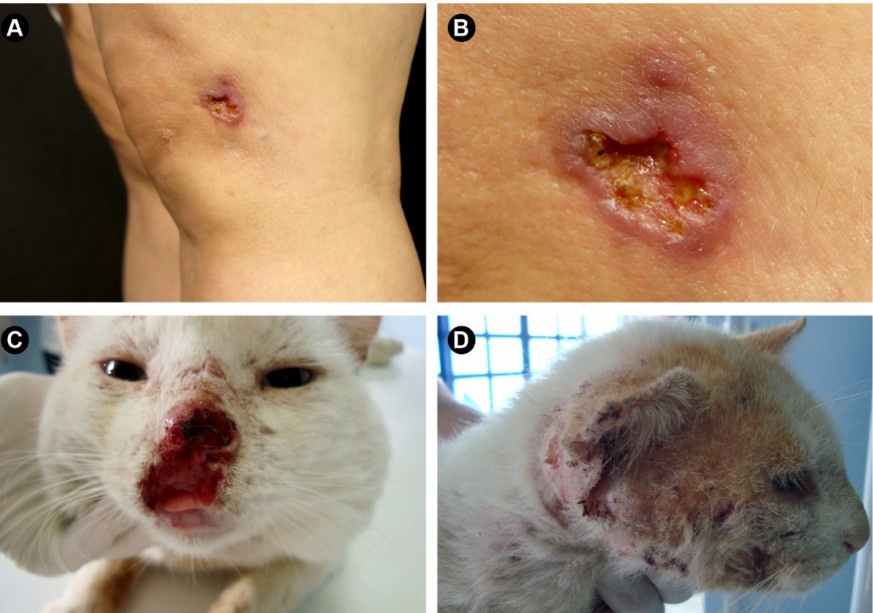
Figure 2. Human and feline sporotrichosis. ( A , B ) Human sporotrichosis on the left knee. ( C , D ) Feline sporotrichosis with lesions in the nasal and cephalic region. Images of cats with sporotrichosis were kindly provided by Prof. Dr. Mario Augusto Ono (State University of Londrina,